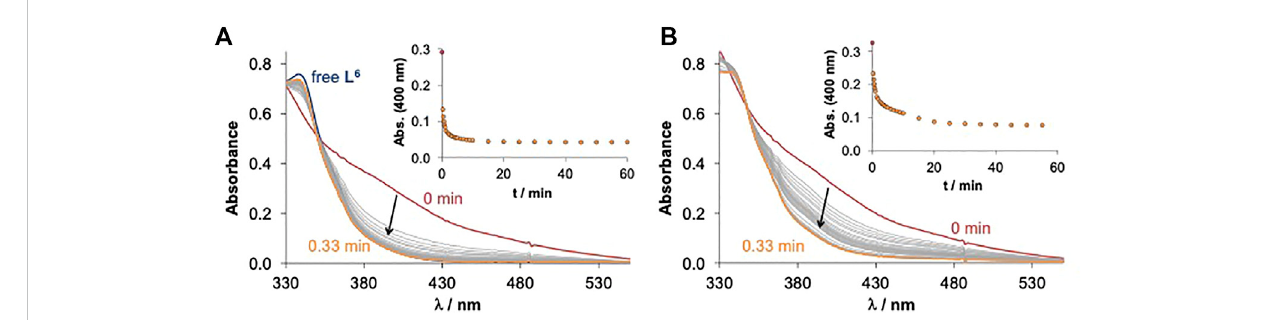
FIGURE 6 Time-dependent changes of the UV-Vis spectra of the Cu(II) complex 6 (40 µM) in the presence of 100 equiv. (A) GSH (4 mM) and (B) AA (4 mM) at pH 7.4 in 5% (v/v) DMSO/H 2 O under anaerobic conditions. Inserted fi gures show the changes in absorbance values plotted against time at 400 nm [t = 25.0 ° C; I = 0.10 M